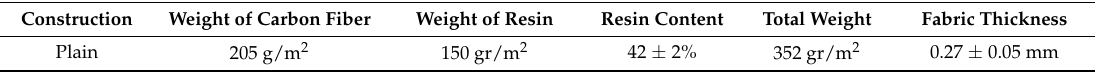
Table 2. Mechanical Properties of carbon fiber (T300-3K-50, TORAY INDUSTRIES Inc., Tokyo,